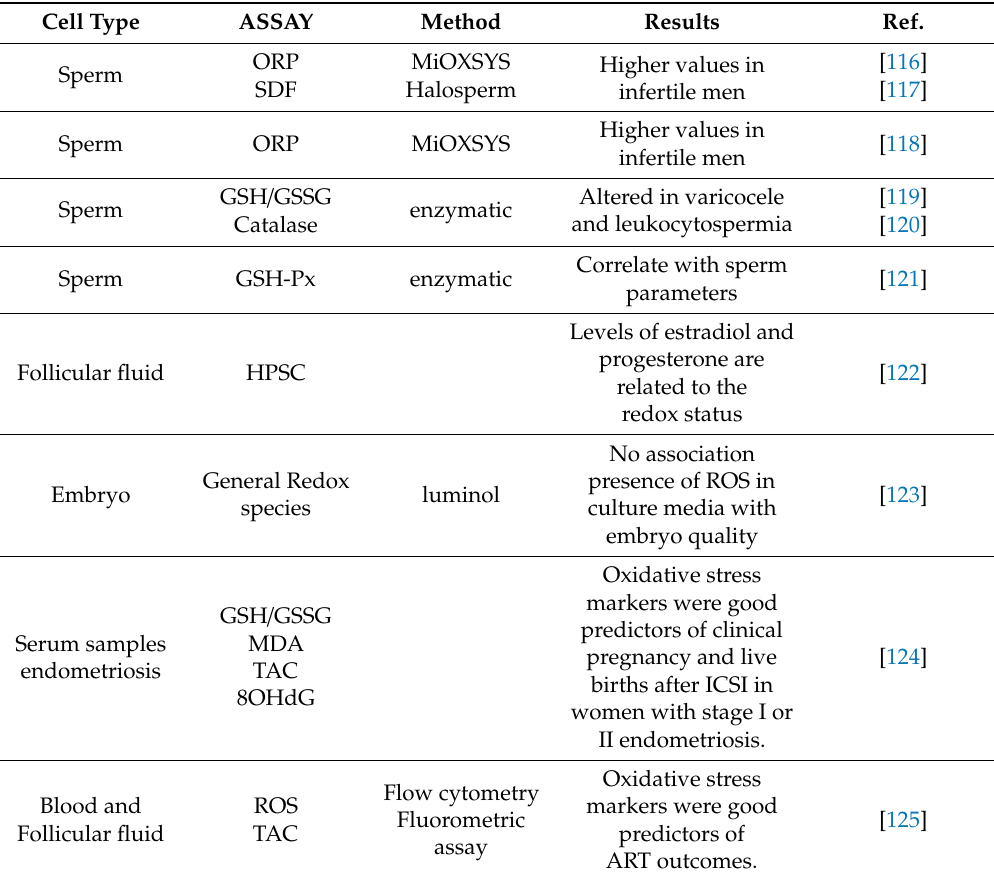
Table 1. Recent studies analyzing the redox status of (in)fertile people during assisted reproductive technologies (ART)